Question: Express in one sentence what the figure is showing.
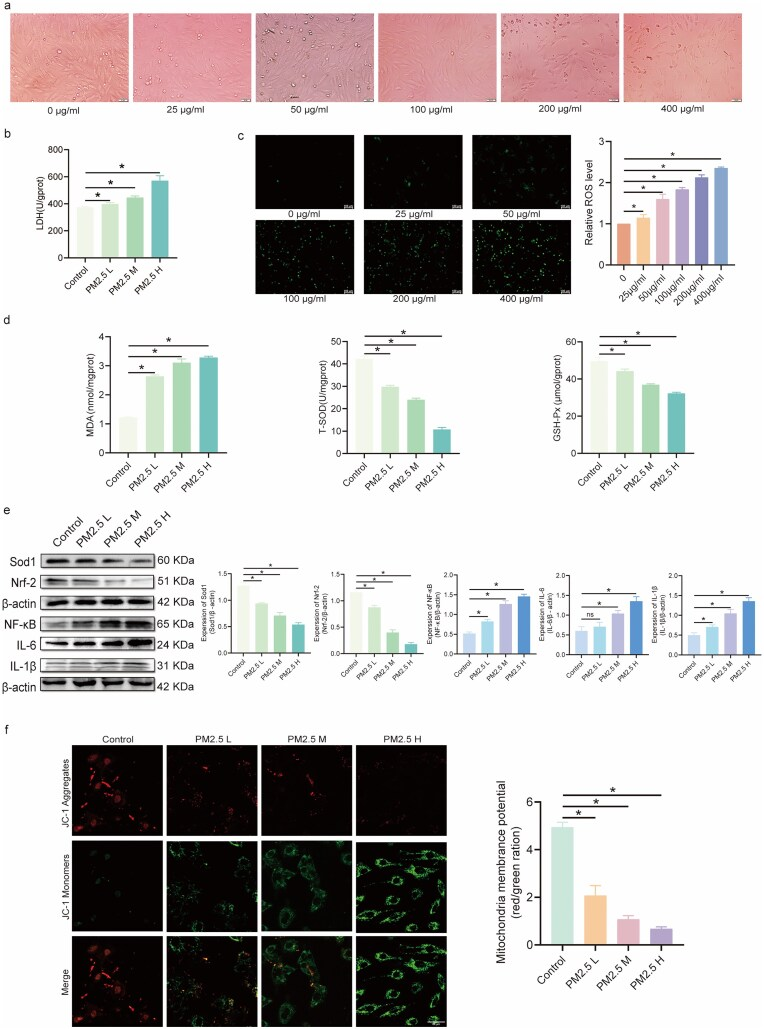
Answer: PM 2.5 exposure causes damage to H9c2 cells. The H9c2 cells were treated with different concentrations of PM 2.5 for 24 h, and the extent of cardiomyocyte damage was assessed. (a) The morphological changes of H9c2 cells after treatment with different concentrations of PM 2.5 and the control group. Scale bar: 50 μm (white, lower right). (b) The changes in LDH release levels in H9c2 cells following exposure to PM 2.5 . (c) The effect of different doses of PM 2.5 exposure on cellular ROS levels. Scale bar: 100 μm (white, lower right). (d) The changes in the levels of MDA, T-SOD, and GSH-Px in each group of H9c2 cells after exposure to PM 2.5 . (e) The changes in the expression levels of Sod1, Nrf-2, NF-κB, IL-6, and IL-1β proteins in H9c2 cells after exposure to different doses of PM 2.5 compared to the control group. (f) The change in mitochondrial membrane potential of H9c2 cells induced by PM 2.5 . Scale bar: 50 μm (white, lower right). The data shown as mean ± SD ( n = 3). ns, P ≥ .05; * P < .05.